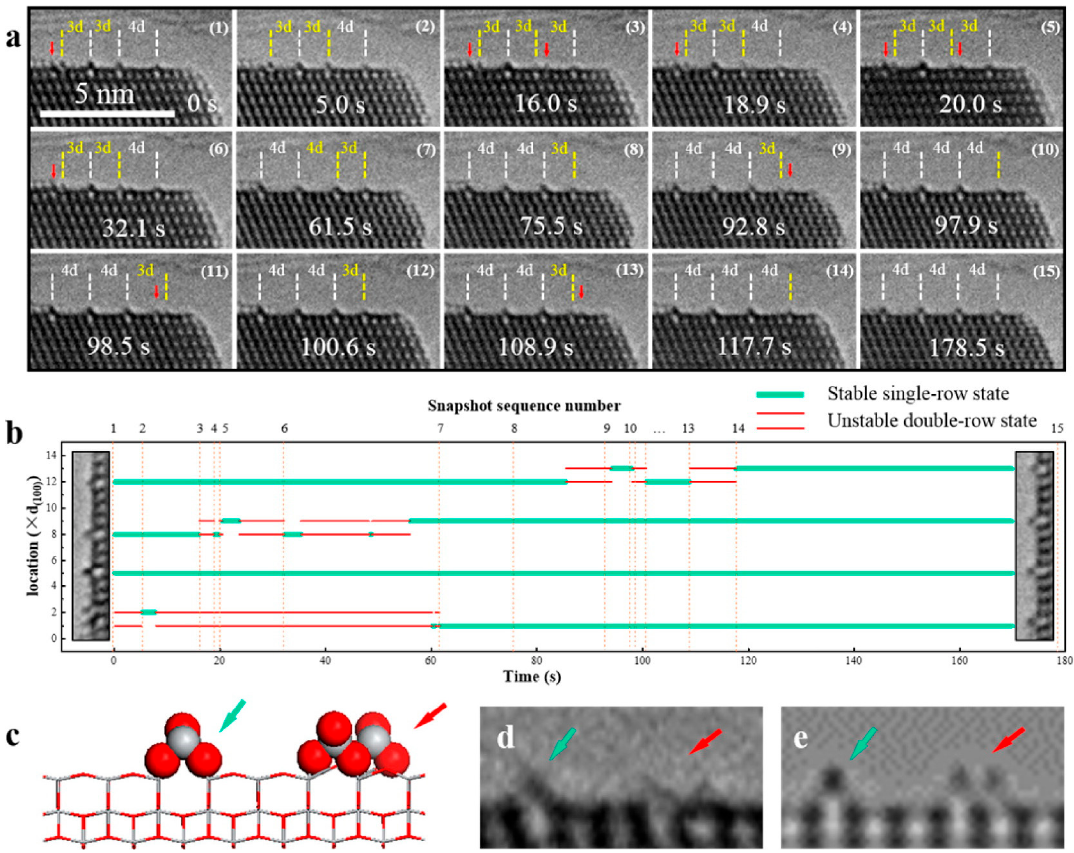
Figure 11. Atomic evolution of the (1 × n ) reconstructions on anatase TiO 2 (001) surface. ( a ) Sequential HRTEM images of the dynamic structural evolution, viewed from [010] direction, with the red arrows indicating the unstable states; ( b ) The statistical diagram of the locations of the TiO x rows with green and red lines indicating the stable states and the unstable states; ( c ) Side view of the proposed model for the unstable two-row state with the TiO x row shown as ball-and-stick (Ti, gray; O, red) on the TiO 2 stick framework. The green and red arrows indicate the stable single-row and instable double-row structures, respectively. ( d , e ) Experimental HRTEM image compared with the simulated image based on the model in ( c ). (Reproduced with permission from [150], American Chemical Society, 2016).